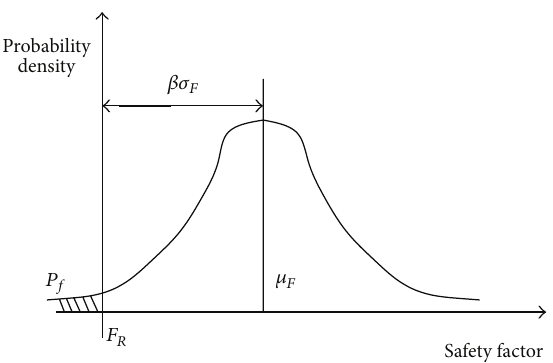
Figure 1: Distribution of dynamic safety